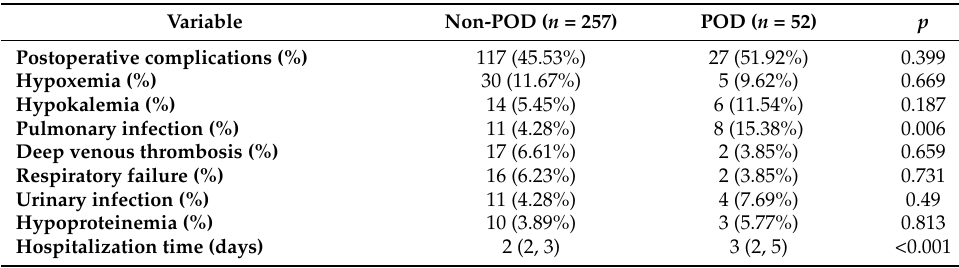
Table 3. Postoperative